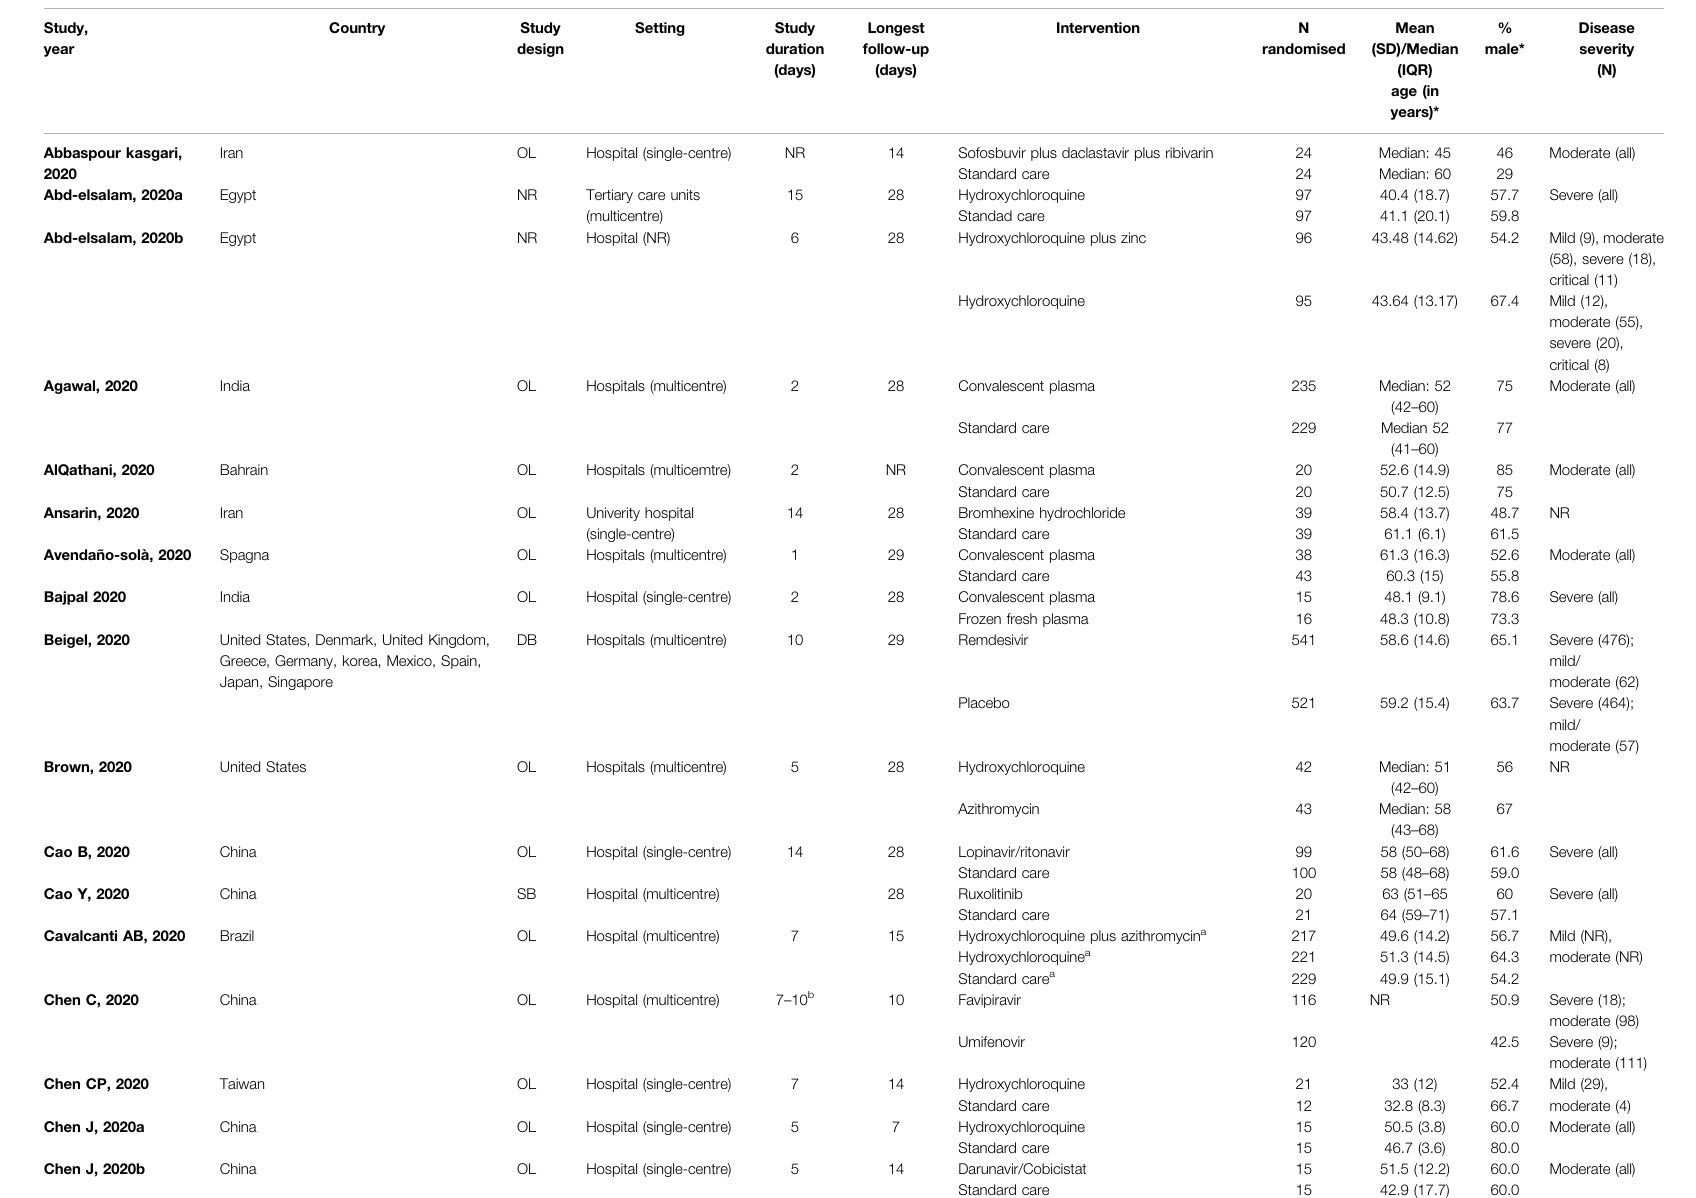
TABLE 1 | Characteristics of included randomized controlled trials. Study,